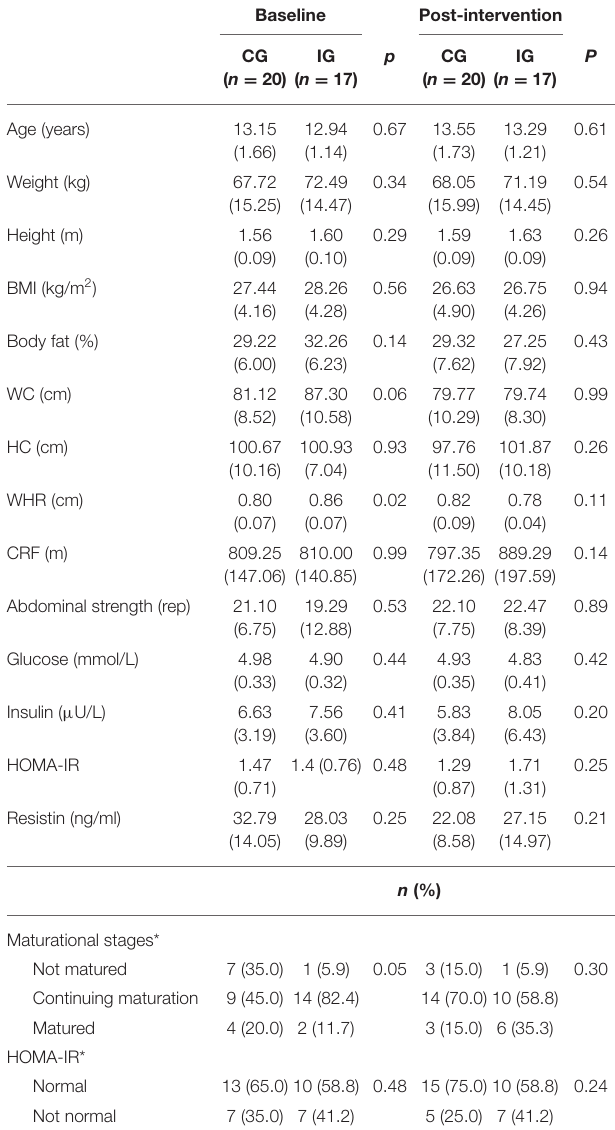
TABLE 1 | Participants’ descriptive characteristics by group.